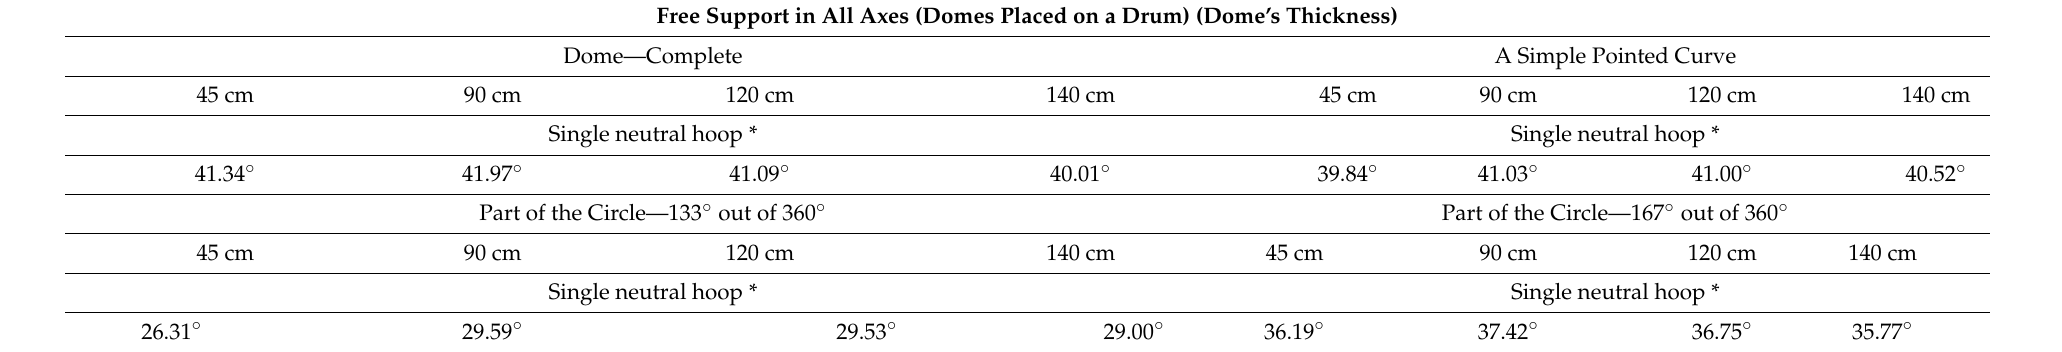
Table 9. Analysis of domes with various thicknesses—R m = 5 m, H drum = 3 m, t drum = 1.1 × t dome , R drum = 5 m. Free Support in All Axes (Domes Placed on a Drum) (Dome’s Thickness)